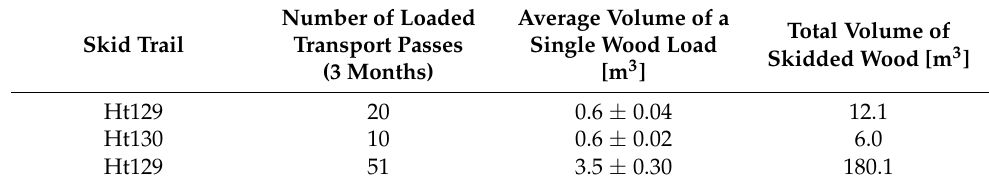
Table 2. Skidding intensity in the study area between dates T1 and T2 (Gorce National Park